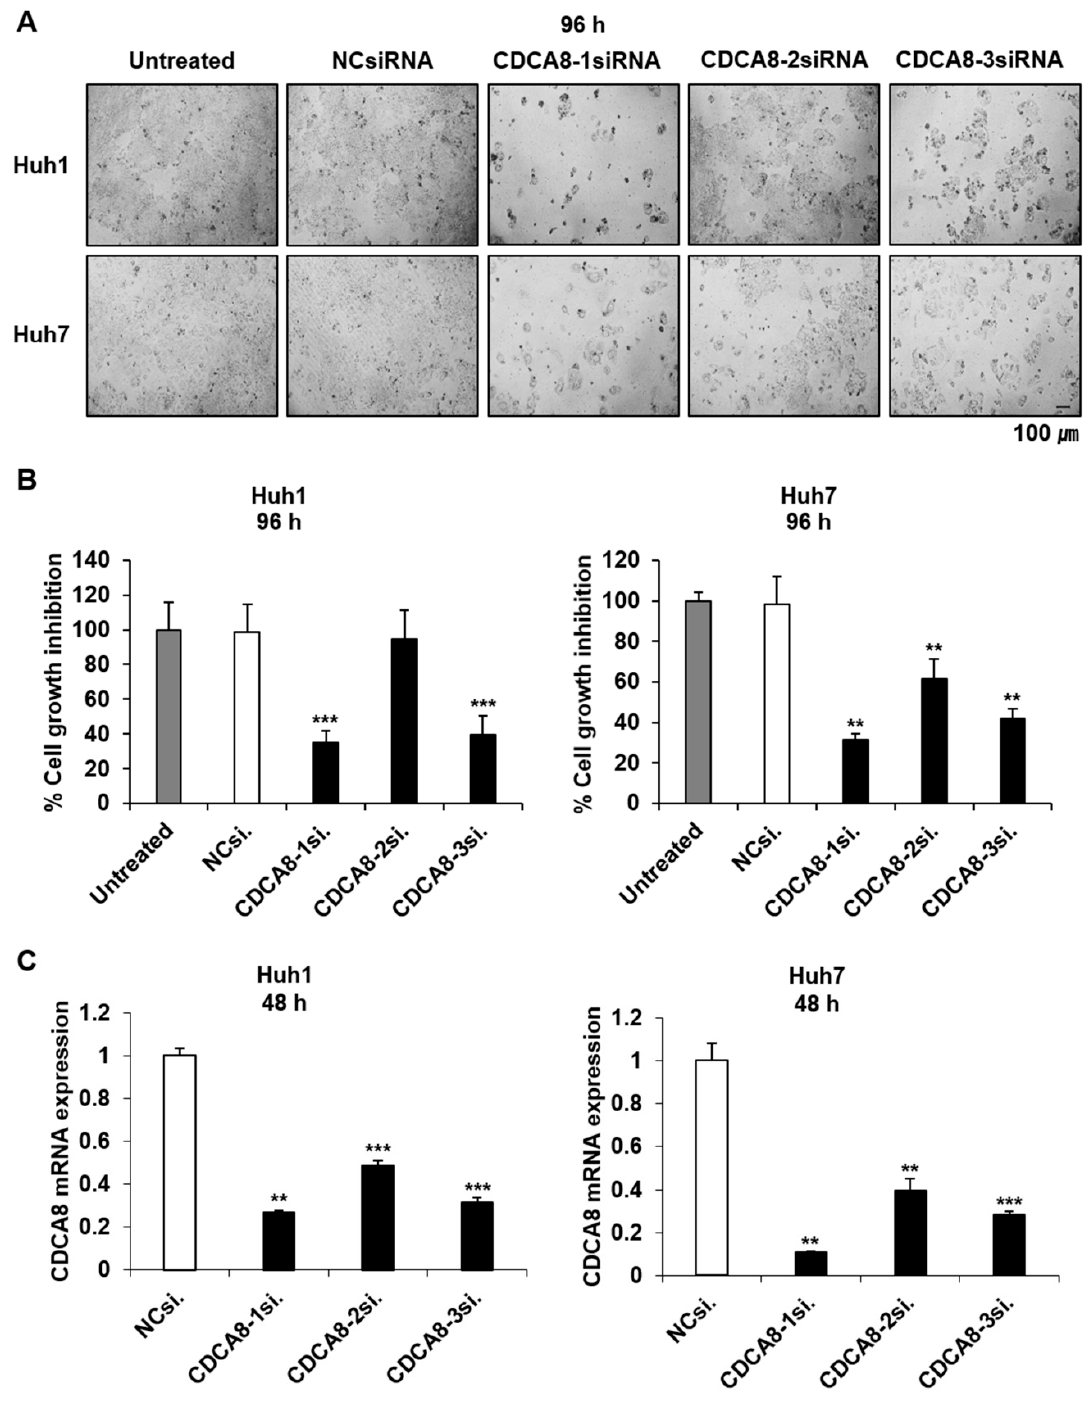
Figure 2. Silencing of CDCA8 suppresses HCC cell proliferation. ( A ) Light microscopy images of Huh1 and Huh7 cells 4 days after NCsiRNA or three kinds of CDCA8-specific siRNA transfection. Scale bar, 100 µ m. ( B ) Growth inhibition of Huh1 and Huh7 cells treated with 15 nM siRNA for 4 days. ( C ) Detection of CDCA8 mRNA expression in Huh1 and Huh7 cells at 48 h after transfection. The data are shown relative to GAPDH expression and normalized to NCsiRNA treatment. NCsiRNA , negative control siRNA; CDCA8-1si. , CDCA8-2si. , CDCA8-3si. , three different sequences of CDCA8-specific siRNA. All the data in this figure were statistically analyzed using the Bootstrap t -test. ** p < 0.01; *** p < 0.001 vs. control.